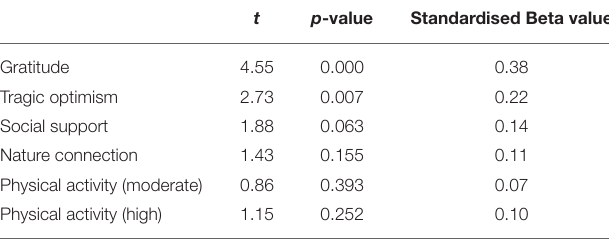
TABLE 4 | Results from the